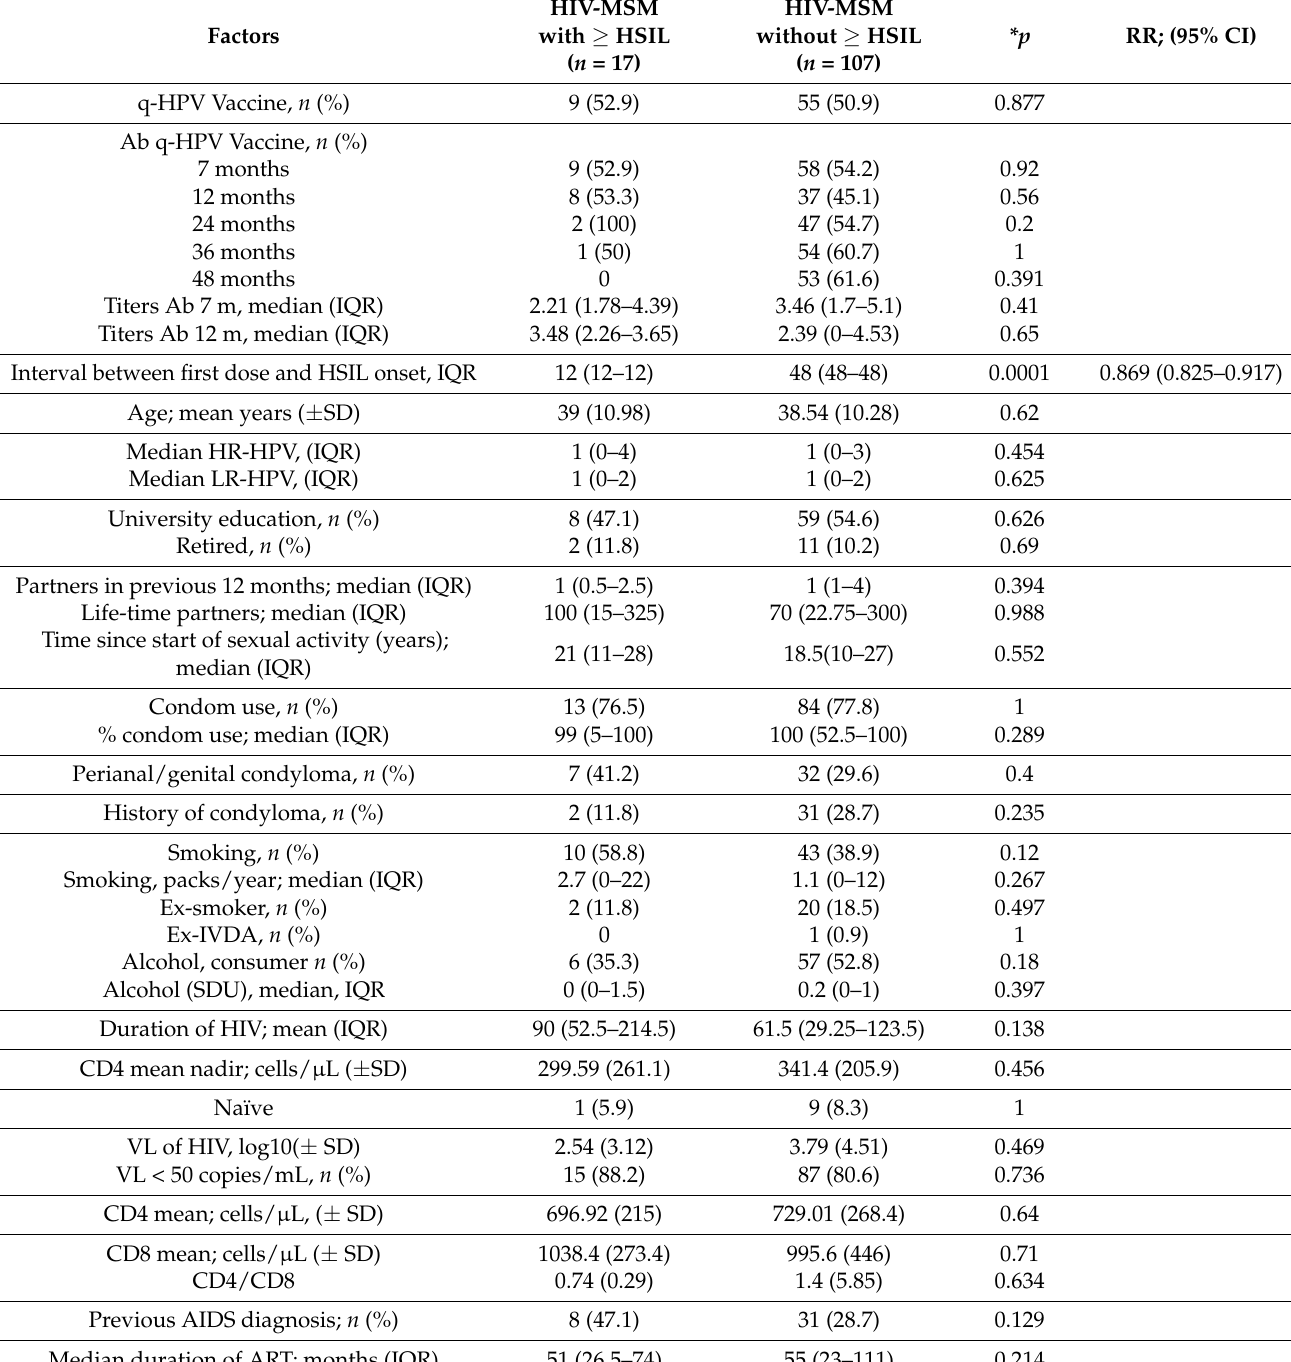
Table 4. Bivariate and multivariate analyses of factors associated with ≥